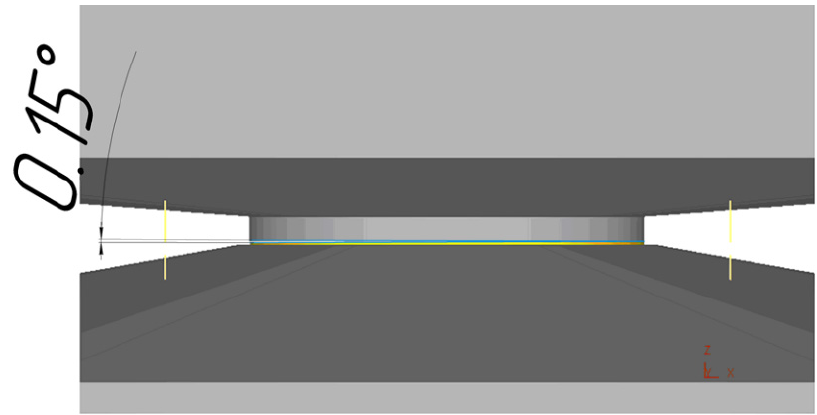
Figure 6. Scheme of the HPT in which the anvils are at an angle of 0.15 ° to each other. Three-dimensional solid models of the workpiece and anvils were created using the CAD system KOMPAS-3D and saved in “stl” format. A grid of finite elements— tetrahedrons—was generated. The number of finite elements was chosen based on prelimi- nary calculations and was 75,000. The modeling was carried out taking into account the volume compensation of the workpiece model. The anvil models were not broken into a finite-element